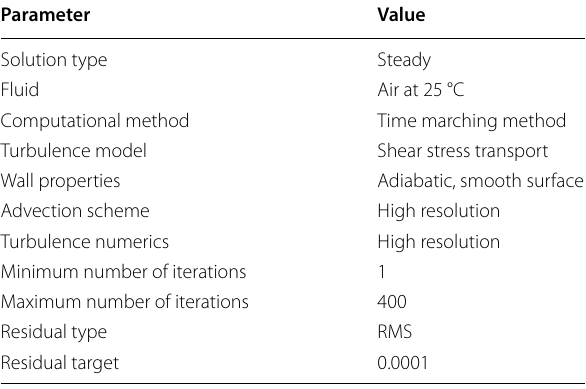
Table 2 Numerical computational parameters